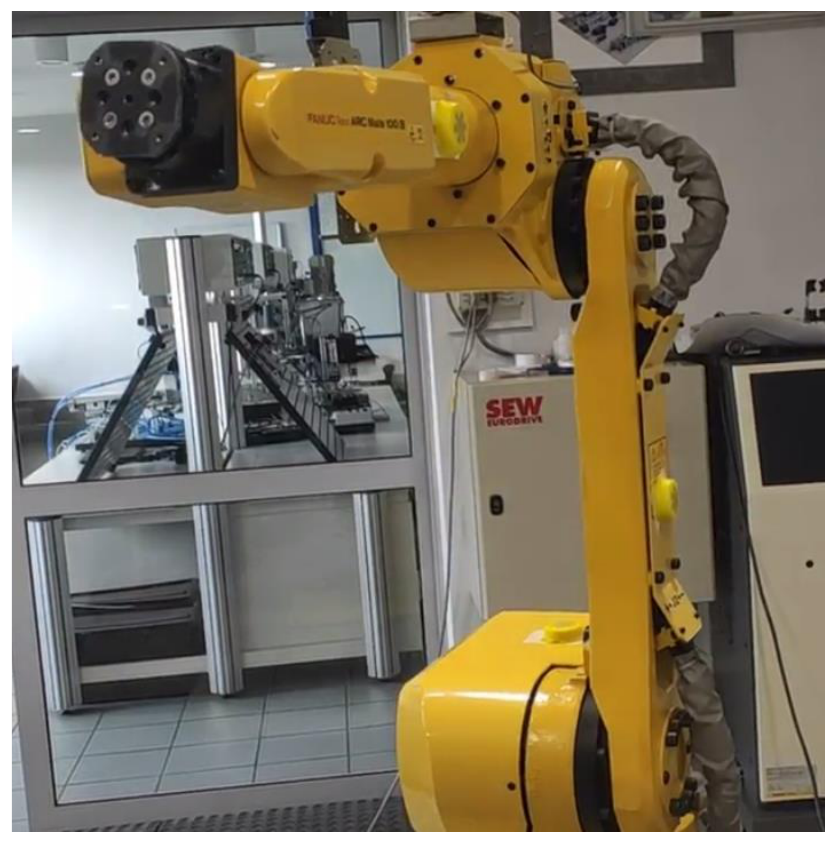
Figure 1. FANUC ARC Mate 100iB industrial robot with marked IMU sensors and encoders.